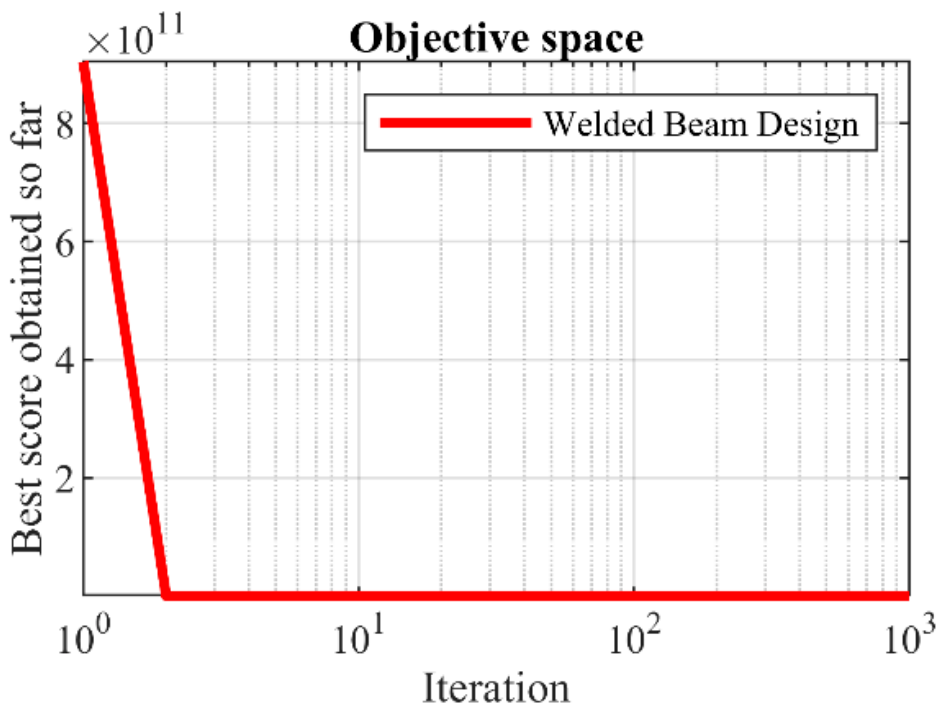
Figure 13. SOA’s performance convergence curve on the welded beam design. The tension/compression spring design is a real-world issue with the goal of minimiz- ing the weight of tension/compression spring. The schematic of this design is provided in Figure 14.